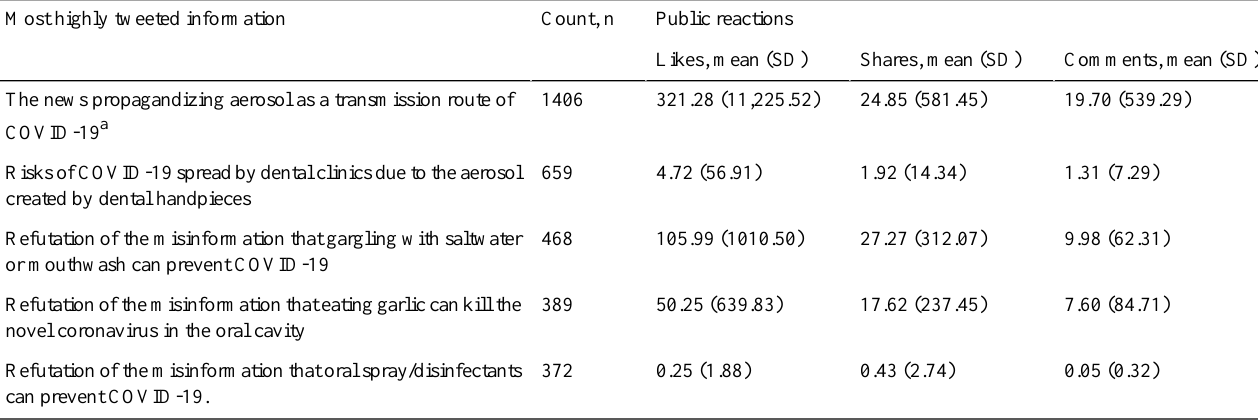
Table 1. Public reactions to highly tweeted information on